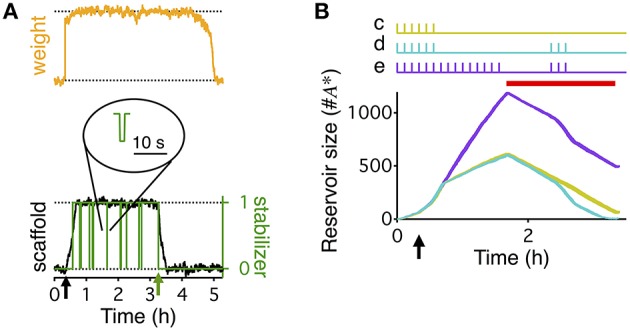
Stabilization of the consolidated synaptic state and reservoir dynamics. (A) Weight (orange), scaffold (black), and binding state (green) of a single synapse in the extended write-protected model (see Materials and Methods section). HFS, to induce LTP, occurs at the point indicated by the black arrow. Green line indicates if the synapse is bound by a stabilizing entity (value of 1), or unbound (value of 0). At around 3 h into the simulation (green arrow) the synapse was artificially set to be “unbound” and kept “unbound” thereafter. This destabilizes the scaffold, causing it to degrade to its low state, which then eventually forces the tag and the weight to decay to their low states as well. Inset circle shows the magnified time course of the binding state of the synapse. While the synapse is big, unbinding of a stabilizer is followed, within a few seconds, by the binding of the same or another stabilizing entity. (B) Evolution of the reservoir of PSI immune stabilizers in response to different stimulation paradigms (shown at the top), corresponding to Figures 1C–E, indicated by the lower case letters next to the stimulations. The reservoir grows until the initiation of PSI, whose duration is indicated by the red bar. The reservoir grows faster in the presence of activity. Once protein synthesis is inhibited, the reservoir decays, decaying faster in the presence of activity. If during PSI the reservoir drops to zero, consolidation degrades because no stabilizing entities are available to stabilize the scaffolds of the consolidated synapses, similar to the scenario depicted in (A). The time axis is magnified compared to Figure 1 (3 vs. 10 h) to highlight the differences in the reservoir dynamics that underlie the different conditions. The width of the line indicates s.e.m averaged over 10 repeats.